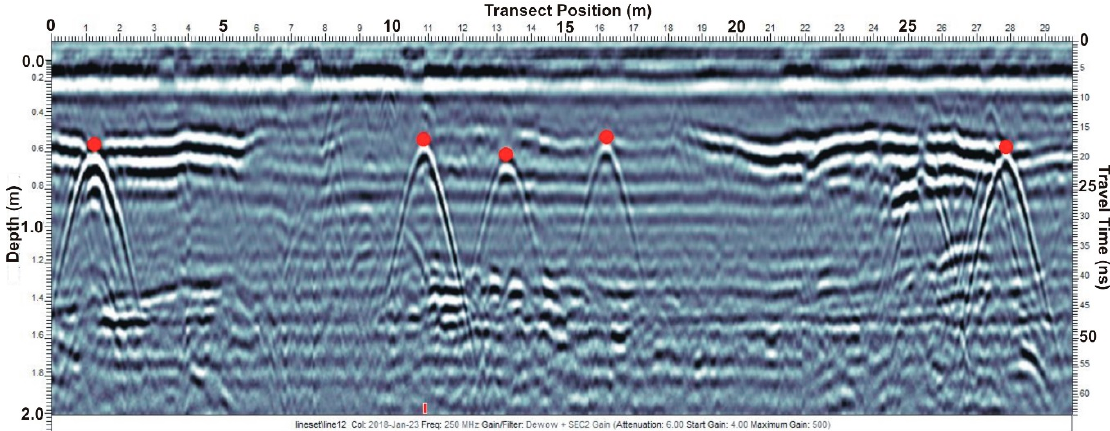
Figure 6. GPR profile from Site 1 with potential reflection hyperbola drainage pipe responses marked via EKKO Project 5. Because GPR and RTK/GNSS data are collected concurrently, the latitude, longitude, and depth corresponding to a potential drainage pipe response mark (red dot) could then all be saved (via EKKO Project 5) into spreadsheet and KMZ files.